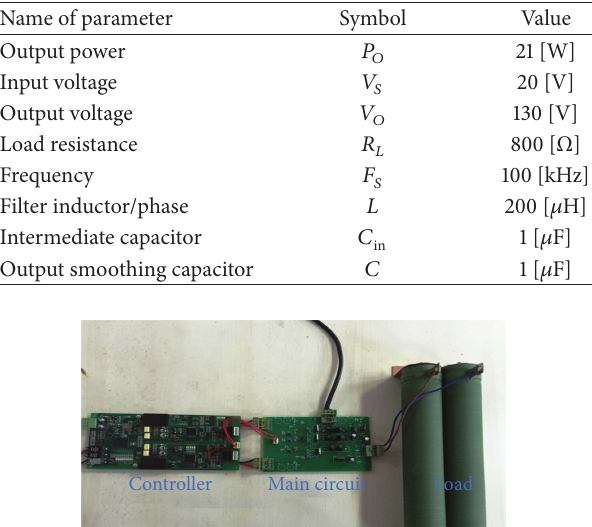
Table 1: Paramaters used for experiment.